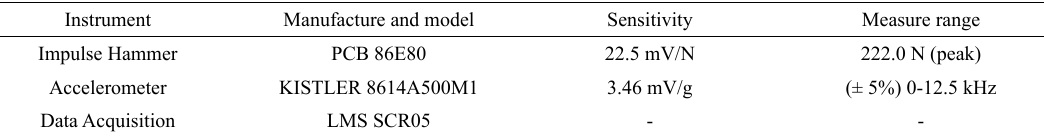
Table 2. Measurement instruments.